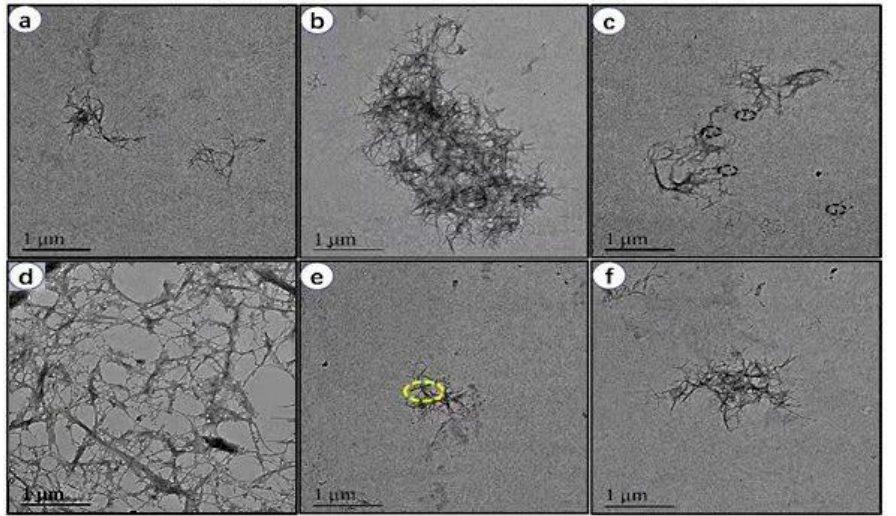
Figure 3. TEM images of lignocellulosic nanofibers (LCNFs): ( a ) TEM image of raw sisal fiber without phosphoric acid treatment. ( b – e ) TEM micrograph of nanofiber after treatment with phosphoric acid. The size of nanofiber is reduced significantly from micrometer to nanometer range. ( f ) Magnified view of selected yellow circle area from panel e.